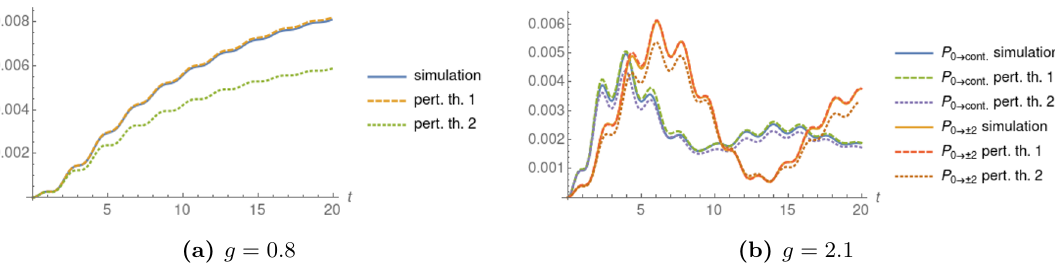
Figure 7. Transition probabilities from the zero mode to continuum and bound states for the toy model. We consider the quasinormal mode case with parameters A = 0 . 1 , γ = 3 . 0 , γ 0 = 1 . 0 and (cid:15) = 0 . 05 . We compare simulation results with first order perturbation theory. The perturbative results are given by eq. (2.10) with the full numerical evolution of the scalar field (dashed) and by eq. (4.11)